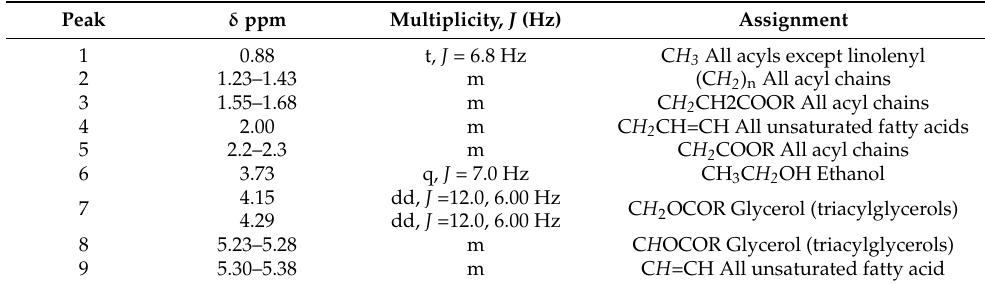
Table 1. 1 H-NMR peak assignment of a typical lipid extract from Tacle juice. Peak labels (1 to 9) agree with those given in Figure